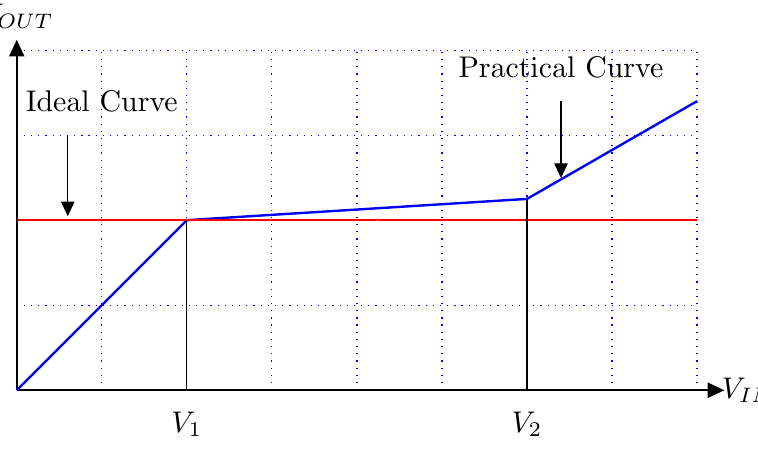
Figure 2. AGC ideal and practical transfer function.